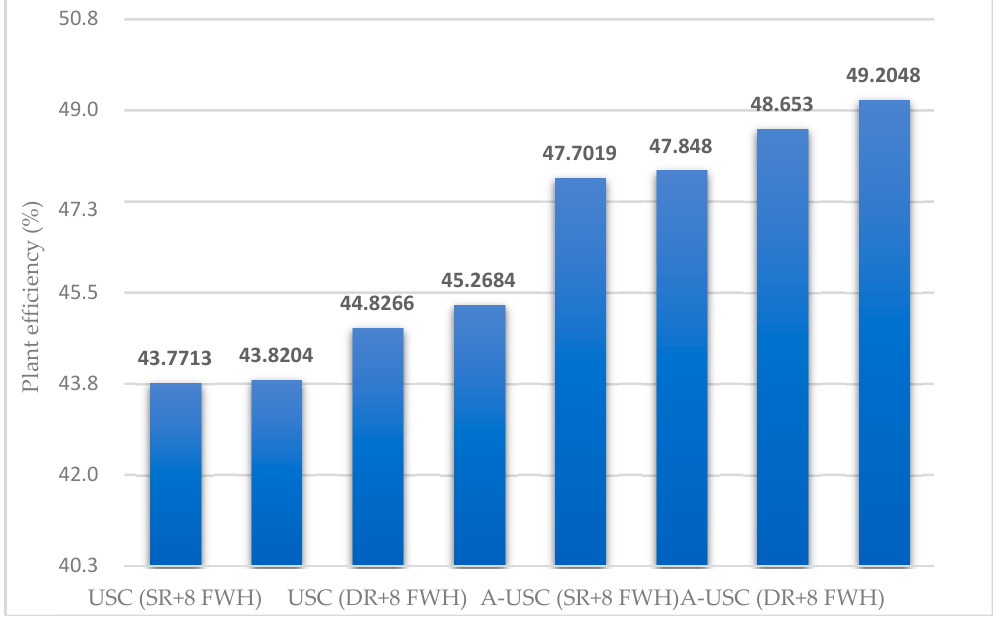
Table 7. Comparison of superheating amongst all models.